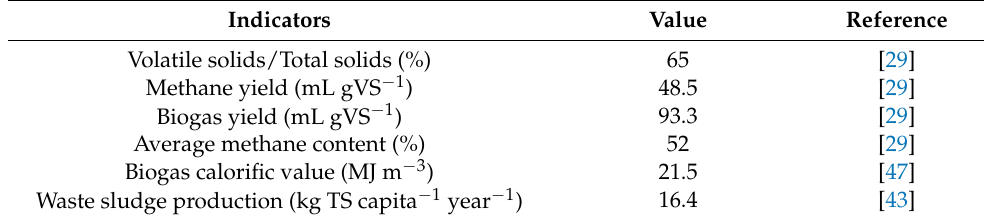
Table 2. Indicators adopted in the case study.